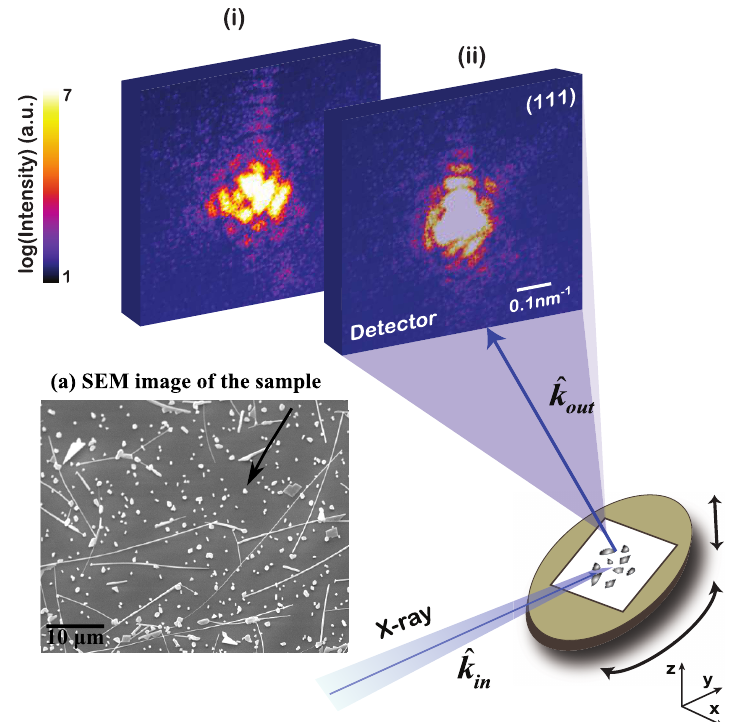
Figure 1. Schematic of the experimental set-up and sample. ( a ) Scanning electron microscopy (SEM) image showing a single isolated Ni nanoparticle (identified by the arrow) in an ensemble of Ni nano-objects. A monochromatic X-ray beam of wave vector (cid:98) k in focused by Kirkpatrick–Baez (KB) mirrors (not shown is sketch impinges on the sample. By rotating the sample through the Bragg condition in increments of about 0.006 degrees, coherent X-ray diffraction (CXD) patterns in the vicinity of the (111) reciprocal lattice point are recorded with a two-dimensional pixelated detector. Two typical diffraction patterns (out of the hundreds of patterns collected) are shown here in